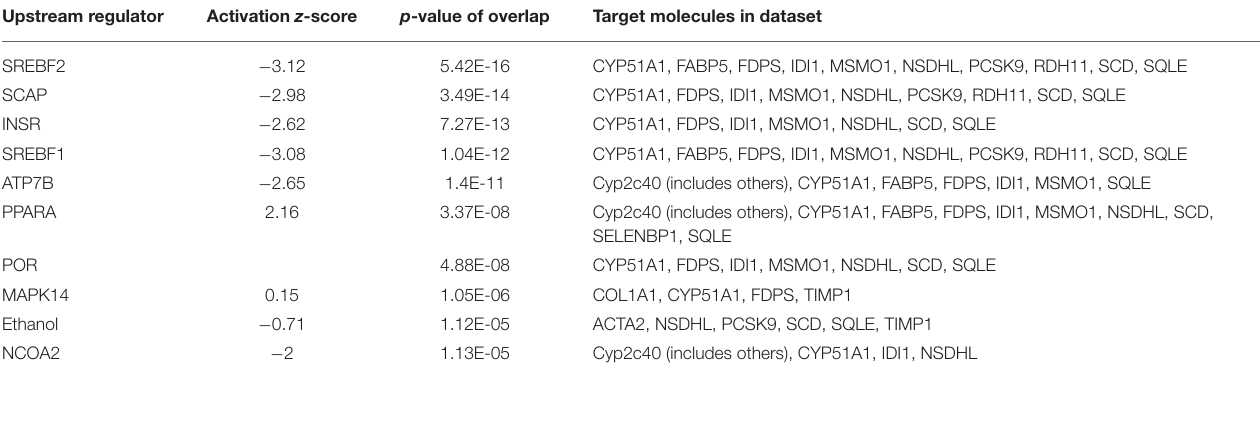
TABLE 4 | Upstream regulators between Phb1 + / − and WT.